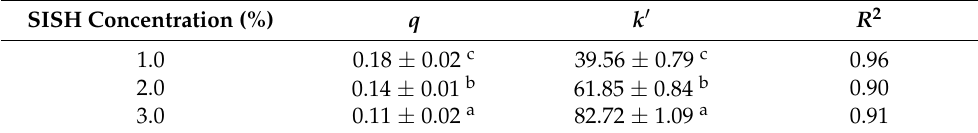
Table 3. Fitted power-law parameters for G’ of SISH dispersions at different